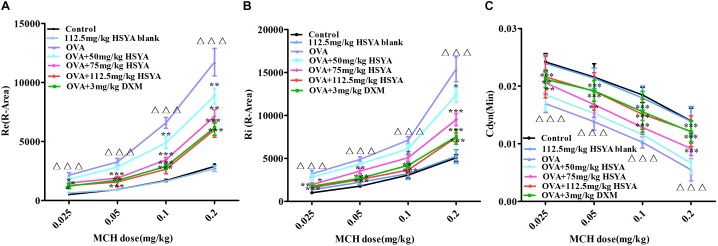
Effects of HSYA on OVA-induced AHR in guinea pigs. Effects of different doses of MCH on (A) relative area of Re; (B) relative area of Ri; (C) minimum value of Cdyn. Data presented as mean ± SD. ∆∆∆
p < 0.001 versus normal control group, ∗p < 0.05, ∗∗p < 0.01, ∗∗∗p < 0.01 versus OVA group.